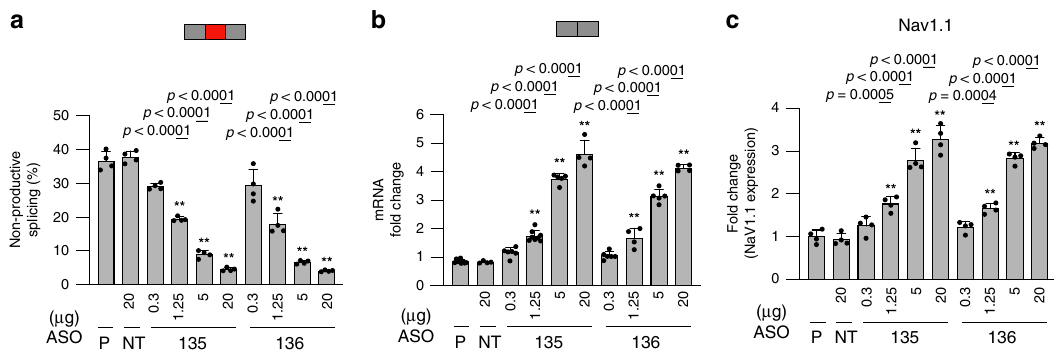
Fig. 6 ASOs increase Scn1a mRNA and Na v 1.1 protein expression in vivo. WT C57BL/6N mice (males and females) were ICV-injected at postnatal 2 with PBS (P), a non-targeting ASO control (NT), and two selected ASOs (135 and 136, human ASOs with perfect match to the mouse sequence) targeting the non-productive exon inclusion in Scn1a . a Percentage of NMD-inducing exon 21x inclusion in Scn1a transcript from mouse brains as quanti fi ed by densitometry of RT-PCR products ( n = 4 randomly selected samples) (Supplementary Fig. 7). b Quanti fi cation of Scn1a productive transcript expression by probe-based qPCR ( n = 9, PBS; n = 4, NT; n = 6, 8, 5, and 4, increasing doses of ASO-135, respectively; n = 6, 4, 5, and 4, increasing doses of ASO-136, respectively. c Quanti fi cation of Na v 1.1 protein expression by MSD ( n = 4 randomly selected samples). Red and gray rectangles denote NMD-inducing and protein-coding exons, respectively. Data are presented as mean values ±SD. P -values were calculated based on two-sided t -test. Asterisks denote ASOs that are statistically signi fi cant ( p < 0.001) in RT-PCR, qPCR, and MSD analyses. Exact p -values for bars with asterisks are 1.77e-5, 1.46e-6, and 4.25e-7; 9.40e-5, 6.44e-7, and 3.66e-7; 1.33e-9, 9.47e-15, and 5.83e-11; 1.58e-5; 3.17e-12 and 1.20e-15; 0.0005, 2.73e-5, and 1.41e-5; 0.0004, 1.71e-6, and 5.56e-7. Source data are provided as a Source Data fi antibodies (Supplementary Fig. 5d, e, respectively). Results